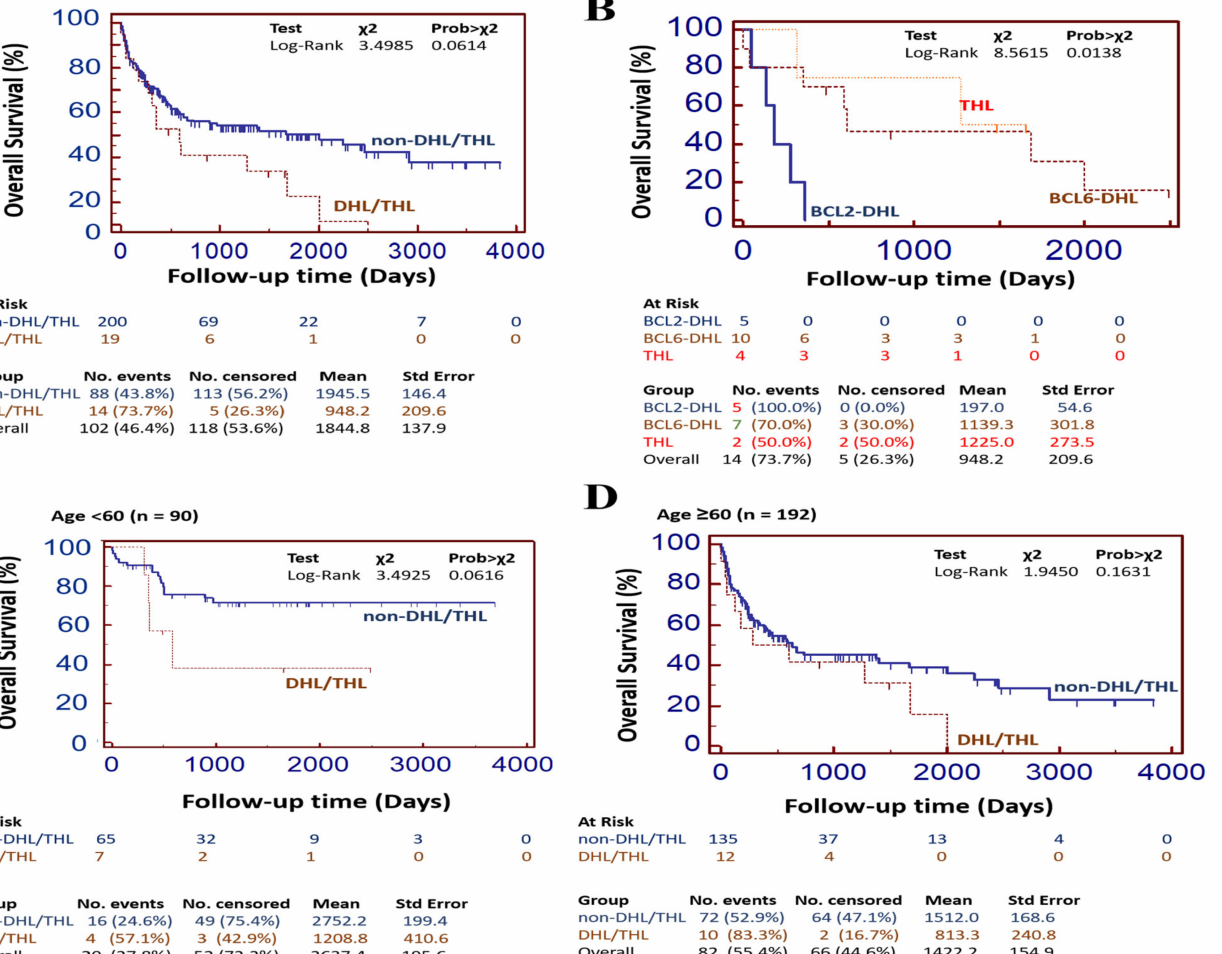
HR(95%CI) = 3.8 (0.64–22.2) vs. BCL2 : HR(95% CI) = 0.6847 (0.2265 to 2.0701)), and our